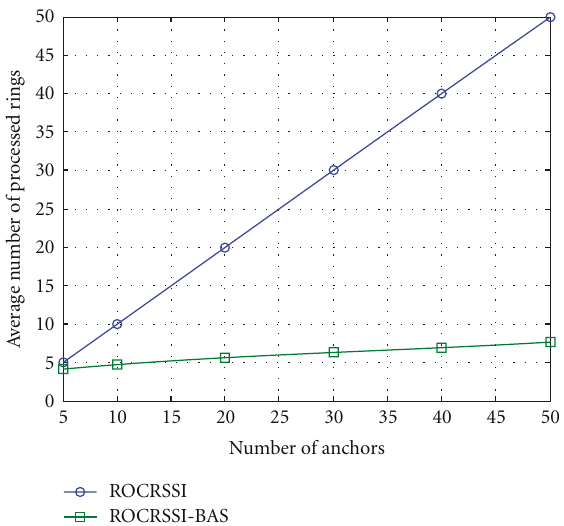
Figure 3: Average number of rings processed at the grid-scan phase.